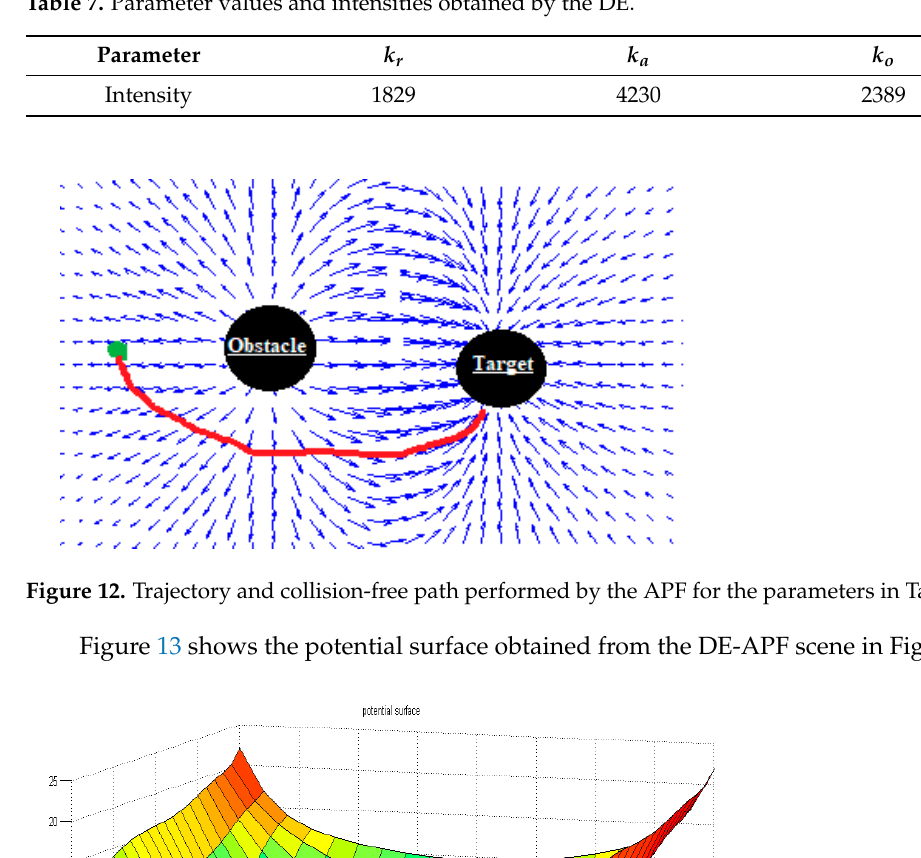
Table 7. Parameter values and intensities obtained by the DE.